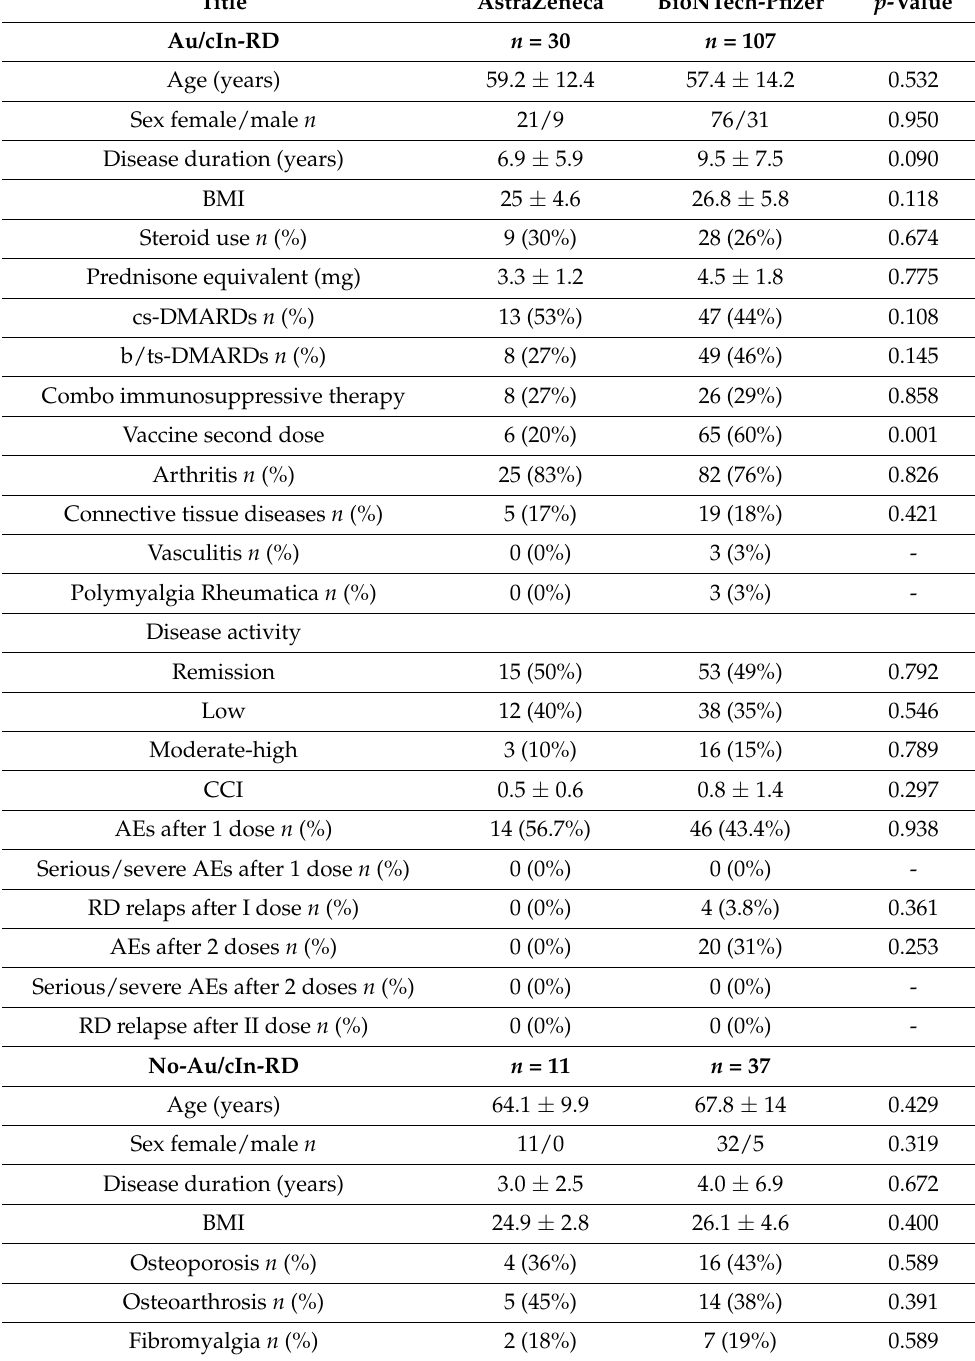
Table 2. Comparison of demographic and clinical characteristics among different vaccines in use in Italy stratified for autoimmune/chronic inflammatory rheumatic diseases (Au/cIn-RD) and nonautoimmune/non chronic Inflammatory rheumatic diseases (no-Au/cIn-RD). Data are shown as mean ± sd or n (%). Statistical significance was set at p ≤ 0.05. AEs: adverse events; CCI: Charlson Comorbidity index; COVID-19: Corona Virus Disease; cs-DMARDs: Conventional Synthetic Disease- Modifying Antirheumatic Drugs; b/ts-DMARDs: biologic/target synthetic Disease-Modifying An- tirheumatic